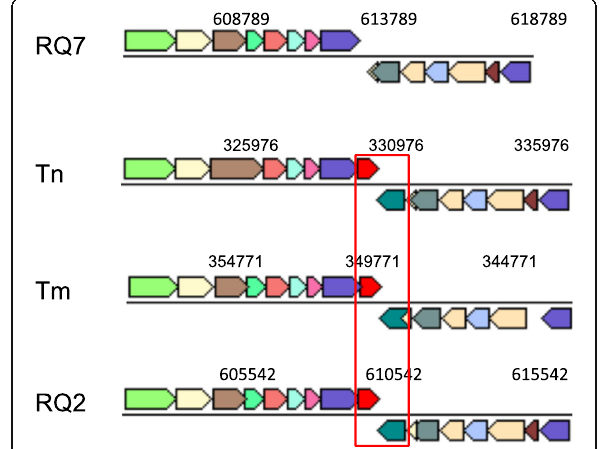
Fig. 6 Deletion of the TneDI system in T. sp. RQ7. The neighborhoods of the deletion site were compared (color by COG categories). The big rectangle box highlights the R-M system that is absent in T. sp. strain Fig. 7 Experimental confirmation of the deletion of the TneDI system